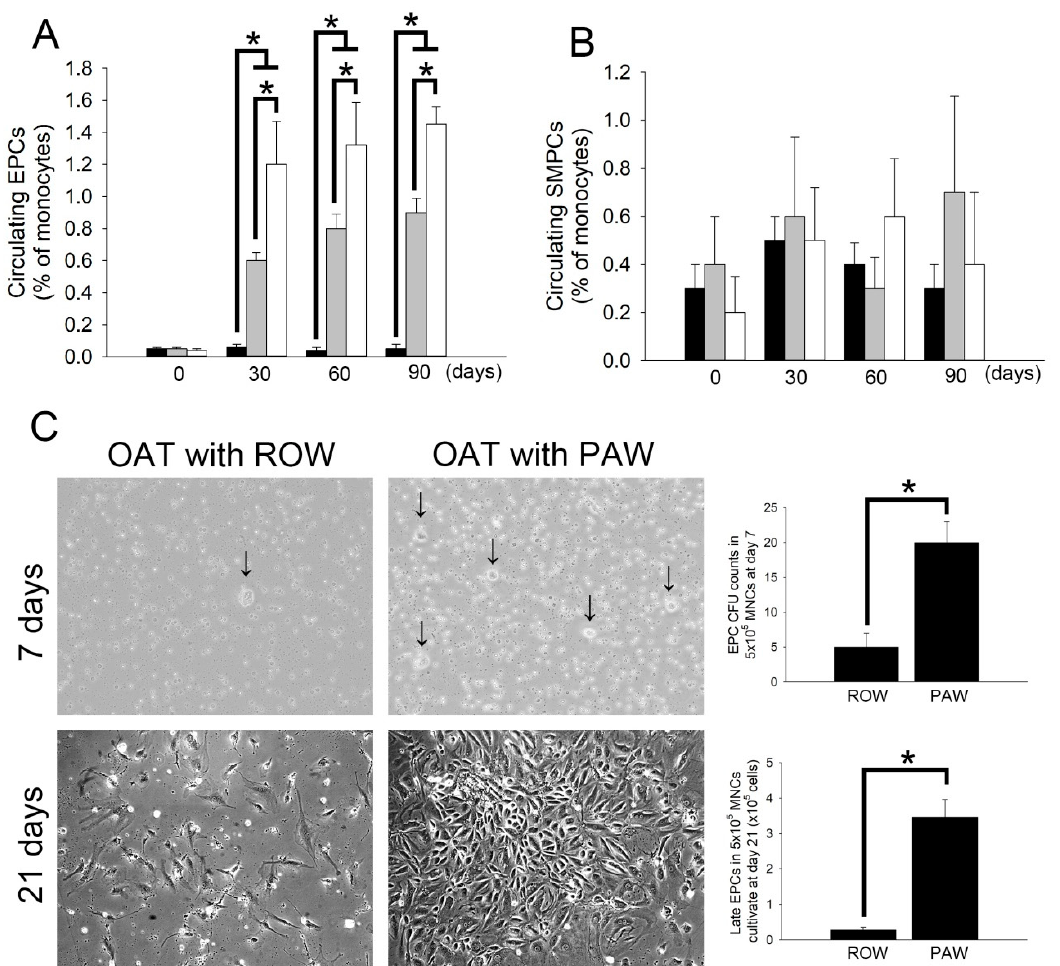
Figure 4. Administration of PAW promotes mobilization of circulating EPCs and differentiation of early EPCs in OAT-recipient ACI/NKyo rats. ( A , B ) EPC (defined as CD133 + /CD34 + /VEGF + cells) and SMPC (defined as CD133 + / α SMA + /CD34 − cells) mobilization at day 30, 60, and 90 following OAT in ACI/NKyo rats was determined by flow cytometry. Quantification of EPCs (left) and SMPCs in OAT-recipient rats (black bar, control group; light gray bar, OAT plus ROW administered group; white bar, OAT plus ROW administration group). ( C ) At the end of the experiment (90th day), MNCs from ACI/NKyo rats were seeded on 6-well plates. Cells were incubated with EGM-2 medium and observed every three days under a microscope beginning on day 7 after seeding the cells. Images at200× magnification on day 7 and day 21 of cultured cells are shown. Arrows indicate the total EPC colony-forming units (CFUs) over 7 days. Right graphs show the number of EPC CFUs (5 × 10 5 MNCs/well in a 6-well plate) over 7 days, and late EPC numbers in 5 × 10 5 MNCs cultured over 21 days in the different groups. All results are expressed as the mean ± SD ( n = 5). Statistical evaluations were performed using Student’s test, followed by Dunnett’s test. * p < 0.05 was considered as significant.